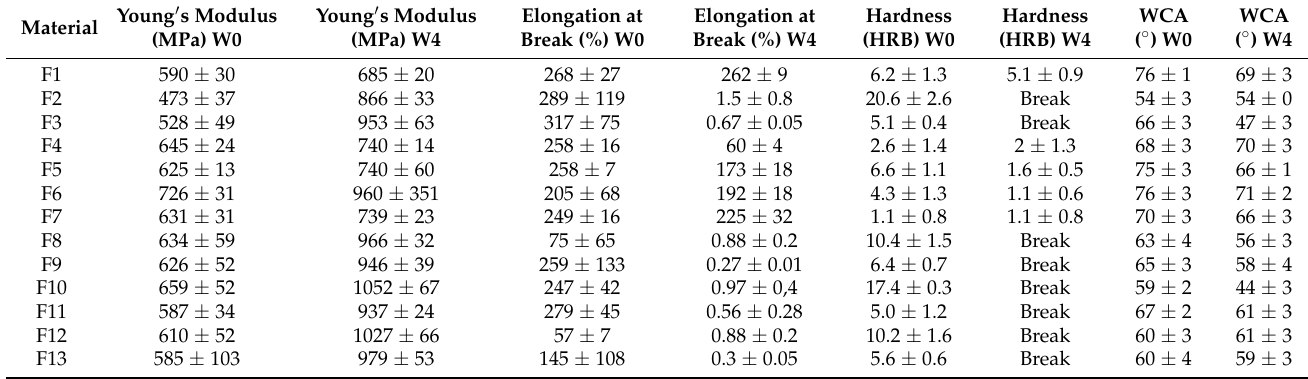
Table 2. Mechanical properties under tensile force: Young’s modulus and elongation at break for all characterized materials; surface hardness and contact angles measurement (wettability). Measurements done at week 0 (W0) and after 4 weeks aging